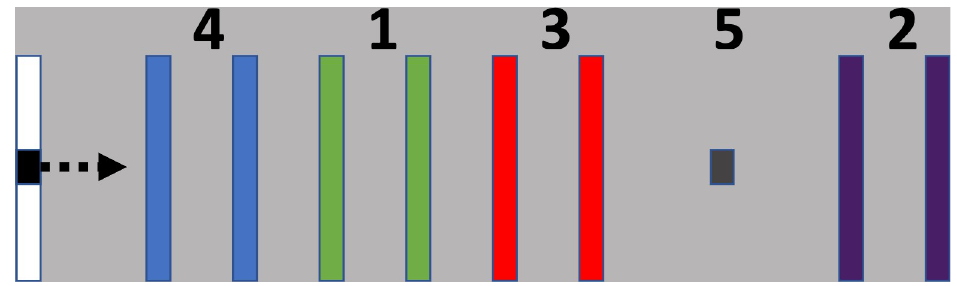
Fig 2. Sequential visuomotor isometric pinch force task. Participants navigate the on-screen cursor between the Home target (black square on the left of the screen) and four other targets, in a sequential order, ending at Target 5.